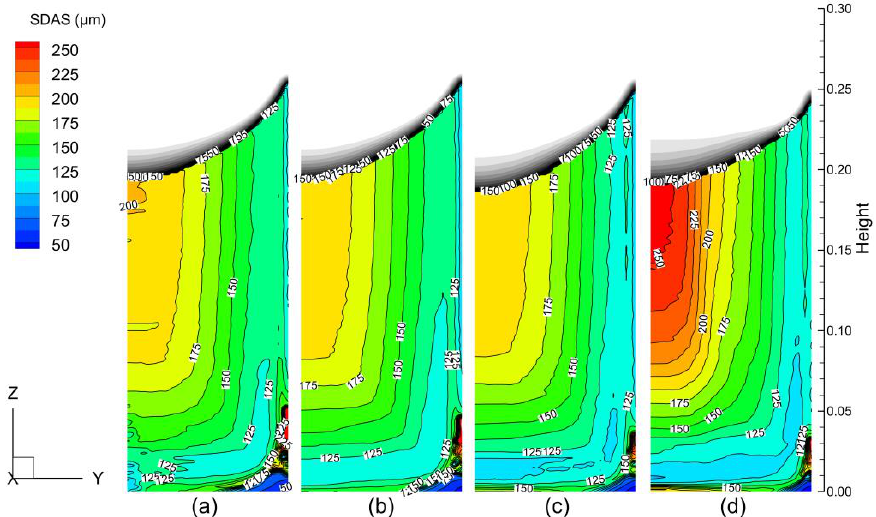
Figure 10. Predicted distributions of SDAS in the solidified ingot with the electrode rotating at different speeds: ( a ) 0; ( b ) 20 rpm; ( c ) 40 rpm; ( d ) 60 rpm.